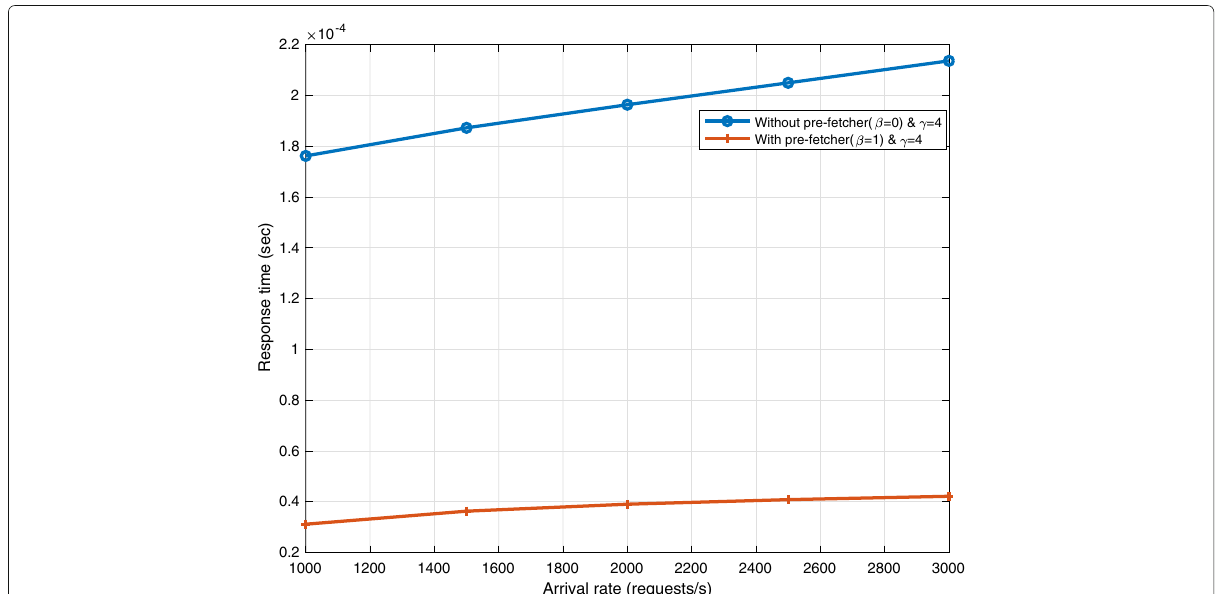
Fig. 3 Response time vs. arrival rate in solo use of the pre-fetcher or multimedia cloud. Without the pre-fetcher ( β = 0 and γ = 4), With pre-fetcher ( β = 1 and γ = 4)